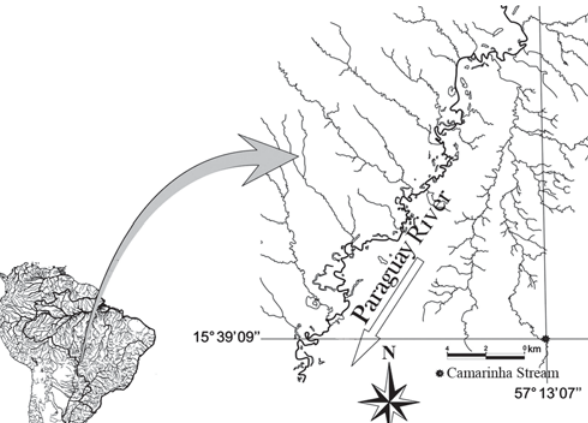
Fig. 1. Study site showing location Camarinha Stream in Serra das Araras, State of Mato Grosso,